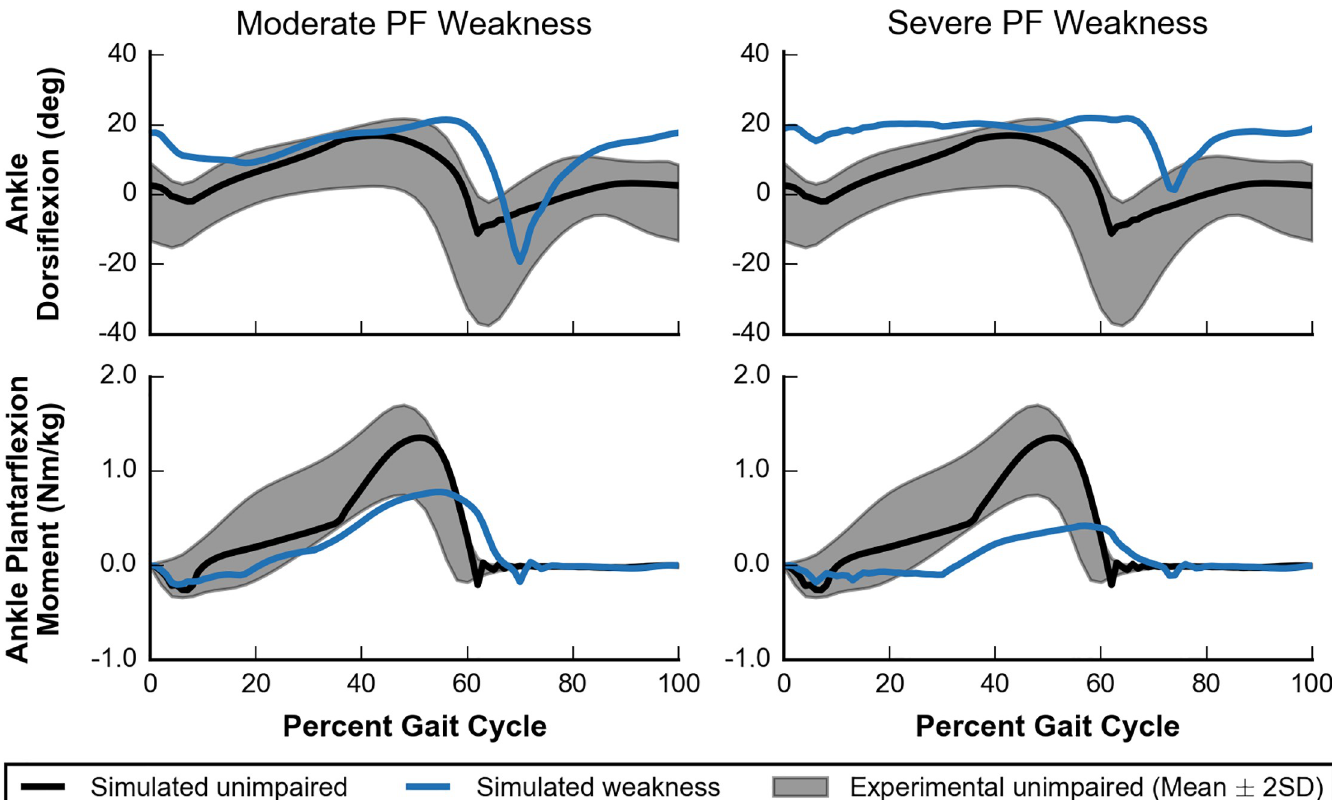
Fig 9. Ankle kinematics and kinetics for moderate and severe PF weakness. Simulated ankle kinematics and kinetics for unimpaired walking (black lines) and walking with PF weakness (blue lines) are compared to experimental data of unimpaired individuals (gray area) [58]. Ankle dorsiflexion (top) and ankle plantarflexion moment (bottom) are plotted for cases of moderate (left) and severe (right) PF